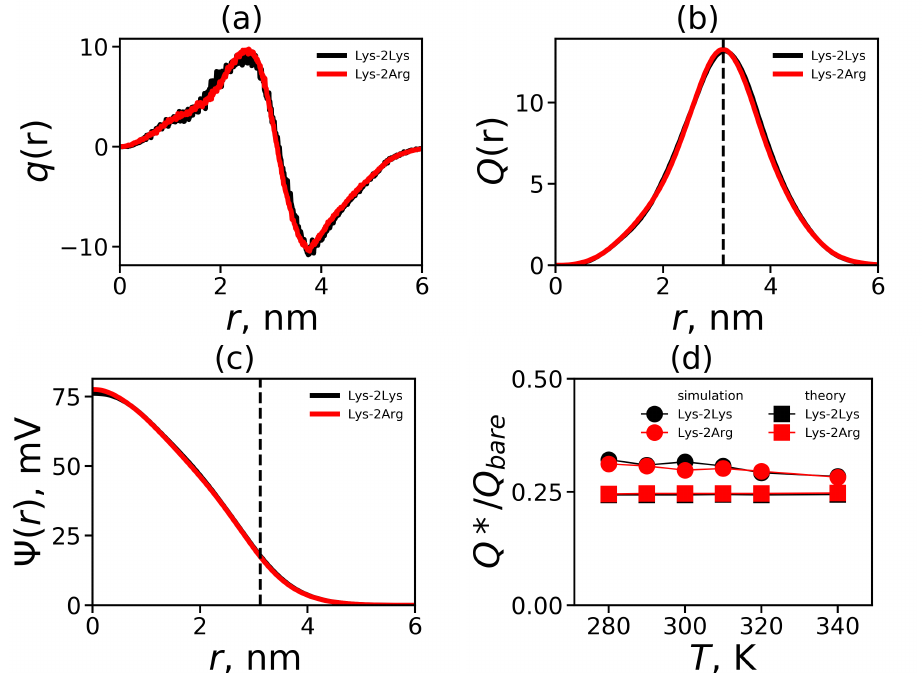
Figure 5. ( a ) The total charge distribution q ( r ) , ( b ) the cumulative charge distribution Q ( r ) , ( c ) the electrostatic potential Ψ ( r ) for Lys-2Arg and Lys-2Lys at T = 310 K; ( d ) the temperature dependencies of the relative effective charge Q ∗ / Q bare for